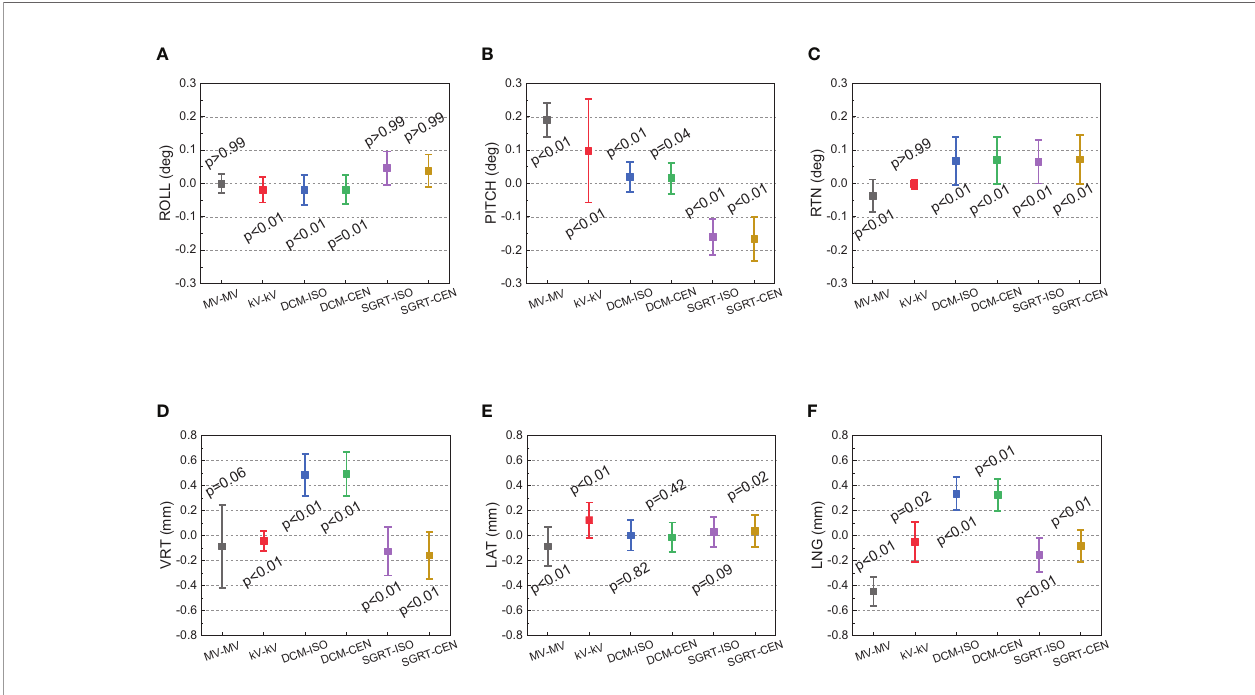
FIGURE 6 | Mean, standard deviation (error bars) of the discrepancies from the CBCT isocenter to kV – kV, MV – MV and AlignRT isocenters over 50 weeks. The mean and stand deviation values are listed in six directions respectively: (A) ROLL (deg), (B) PITCH (deg), (C) RTN (deg), (D) VRT (mm), (E) LAT (mm) and (F) LNG